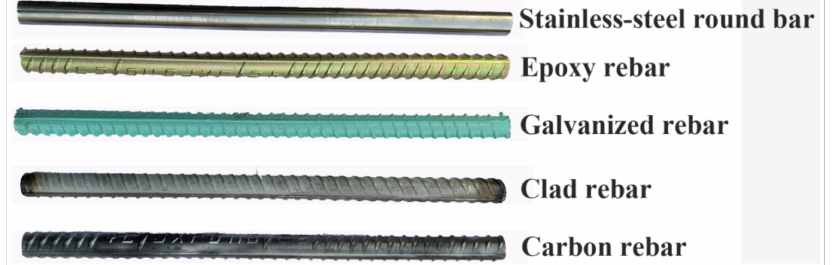
Figure 19. Surface morphology of each specimen before